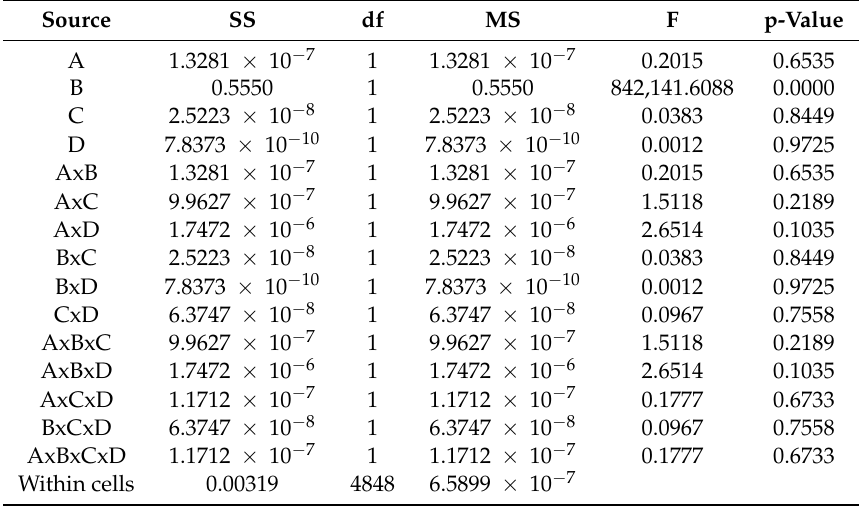
Table A2. Four-way ANOVA table for the expected uncertainty